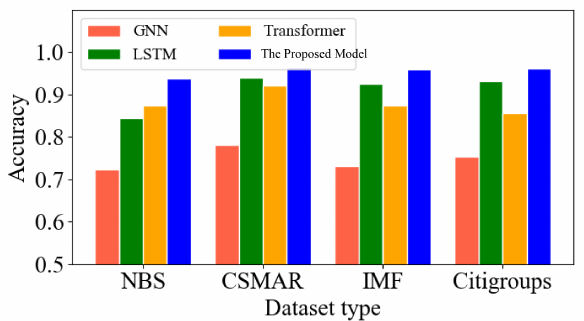
Figure 12. Accuracy in different datasets.